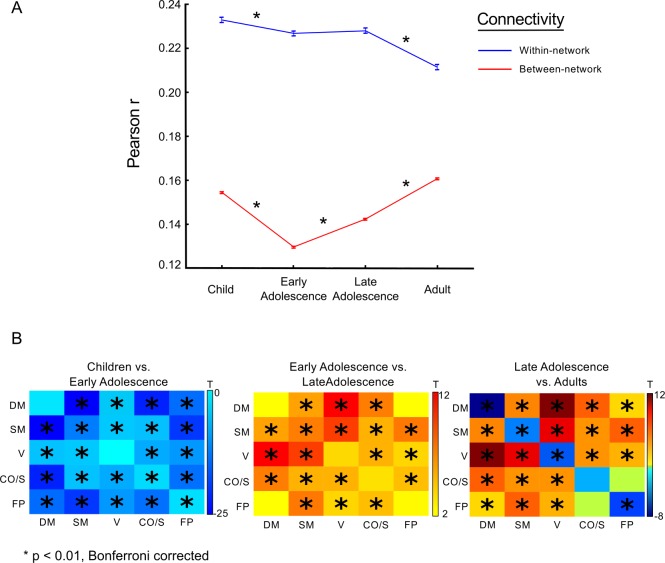
Connectivity strength changes through development as a function of network organization.(A) Connectivity strength changes as a function of within- and between-network connectivity. Asterisks denote significant differences between groups (p < 0.05, corrected) (B) Each cell represents the t-statistic resulting from a t test of connectivity strength between each network contrast. The diagonal represents within-network comparisons (e.g., DM-DM network connectivity strength differences between groups), while off-diagonal elements are between-network comparisons (e.g., DM network and CO/Salience network). Therefore, matrices are symmetric. Asterisks denote significant differences between groups (p < 0.01, corrected). (Data available at http://devrsfmri_2015.projects.nitrc.org/devrsfmri_2015.tar.bz2.)